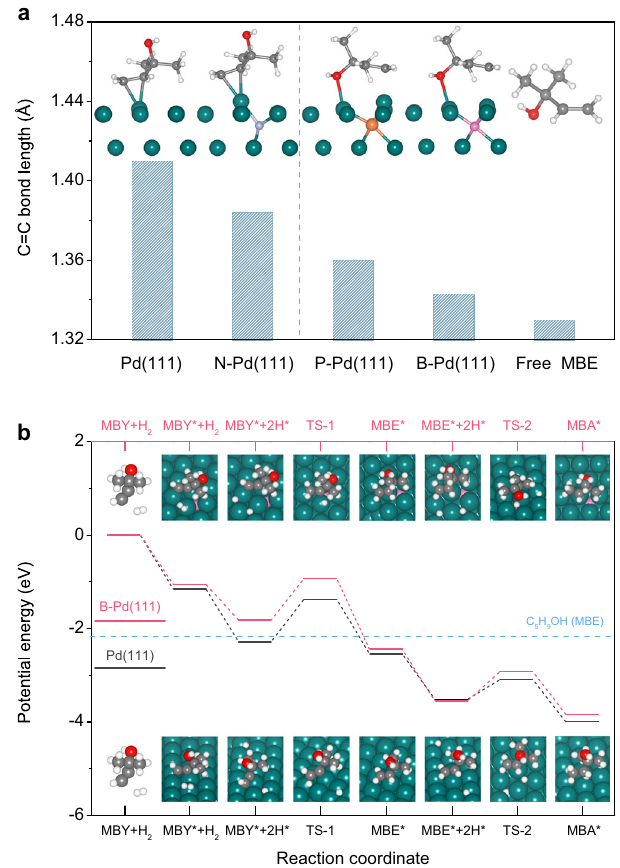
Fig. 4 DFT calculations. a The most favorite adsorption con fi guration and C = C bond length in MBE on the pure Pd(111), and interstitial atoms (B, P, and N) modi fi ed Pd(111) surfaces (Pd cyan, B pink, P orange, N blue, C gray, O red, H white). b Reaction pathway for the semi-hydrogenation of MBY on the pure Pd(111) and B-Pd(111) surfaces. The geometry structure of involved intermediates and transition states (TS) are